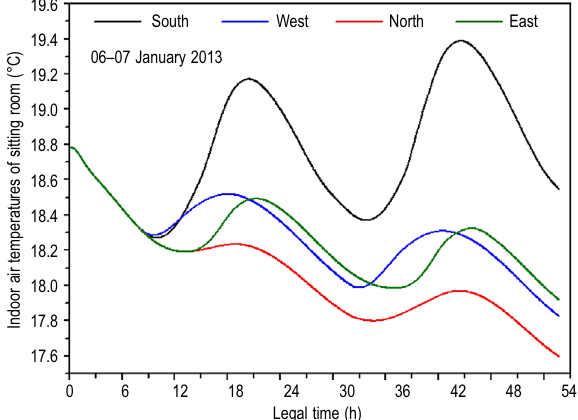
Fig. 10. Sitting room temperatures, S/V ratio =